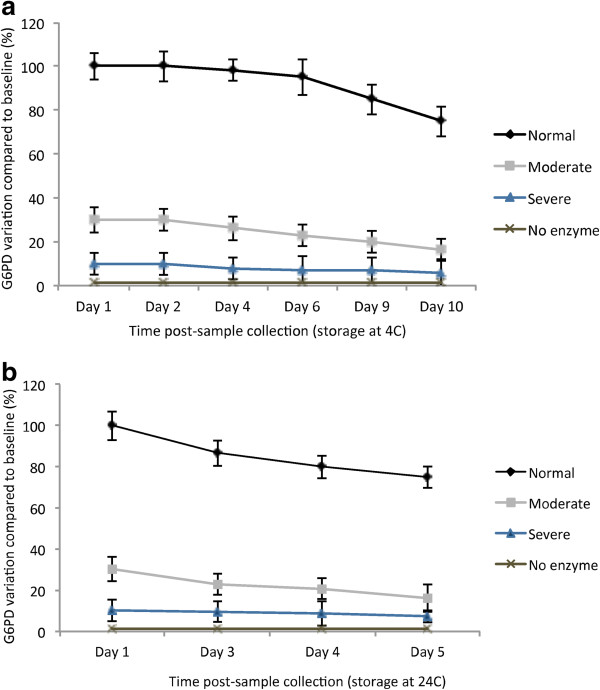
Enzyme degradation due to storage on filter papers. a) 150 filter papers with control blood spots with normal activity, moderate deficiency, severe deficiency, and no enzyme (100%, 30%, 10%, and 0%) were stored for up to 10 days at 4°C, and their activity measured at days 1,2,4,6,9, and 10. b) Samples were stored at room temperature, in the dark, for days 1–5, and the activity measured daily.